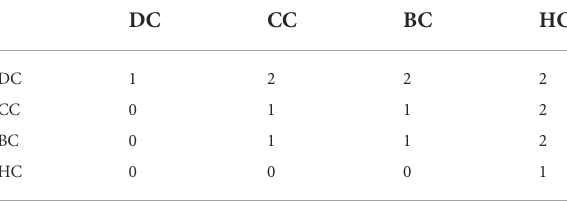
TABLE 1 Comparative values of importance indicators constructed by the three scale